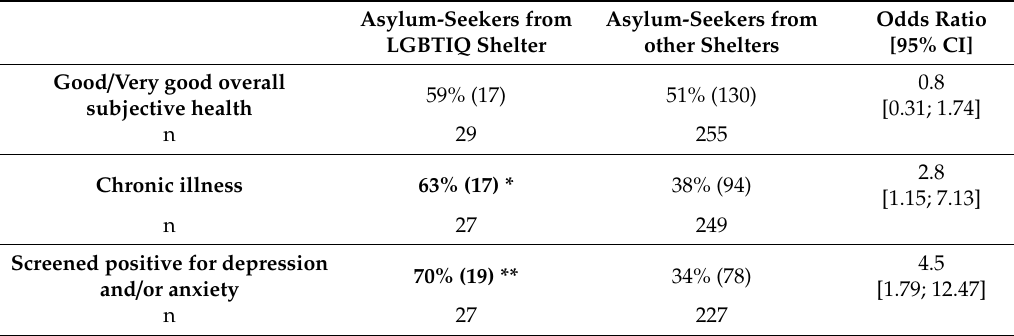
Table 2. Health status (in % (n) of respondents).